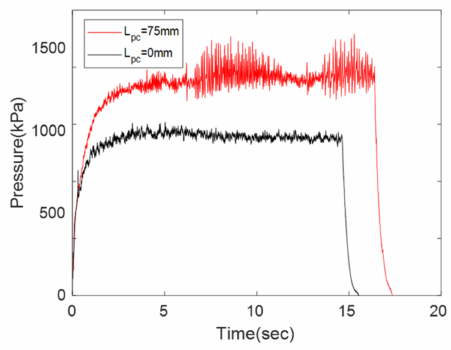
Figure 1. Comparison of combustion pressures with and without the post